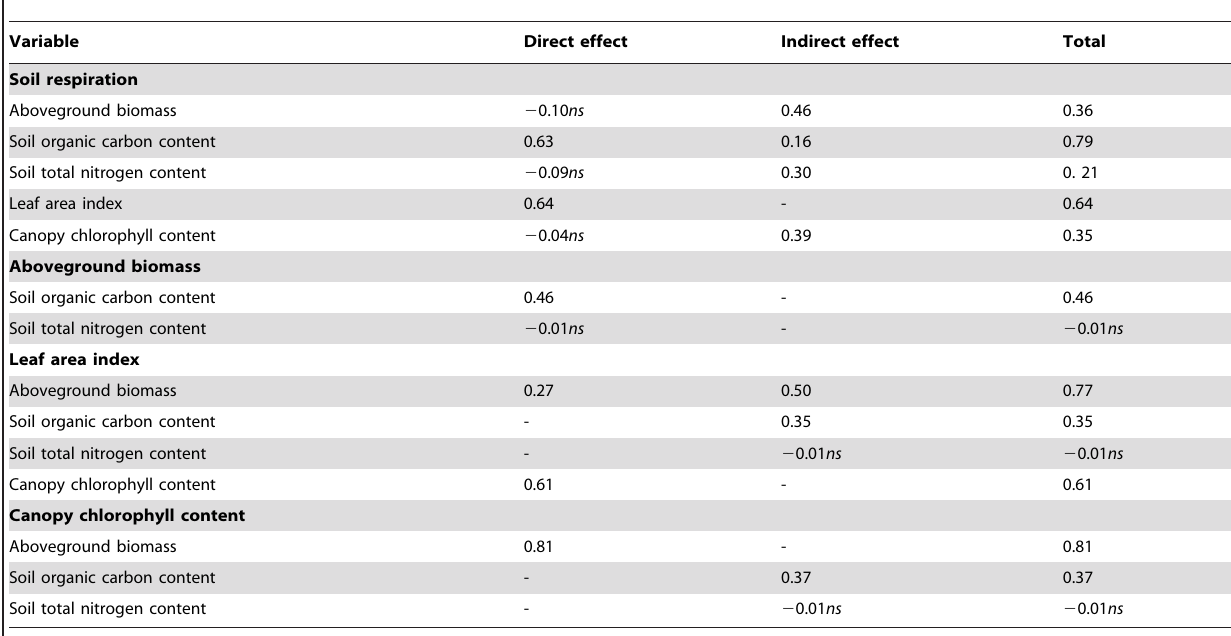
Table 4. Total, direct, and indirect effects in the structural equation modeling.